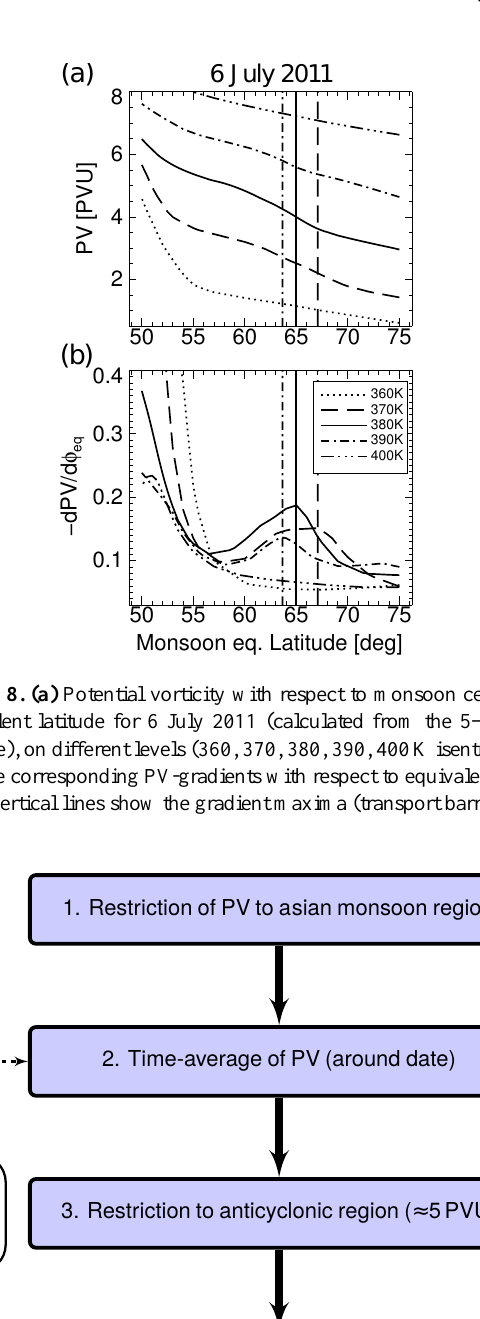
barrier separates the high mixing ratios in the center of the anticyclone from the lower values